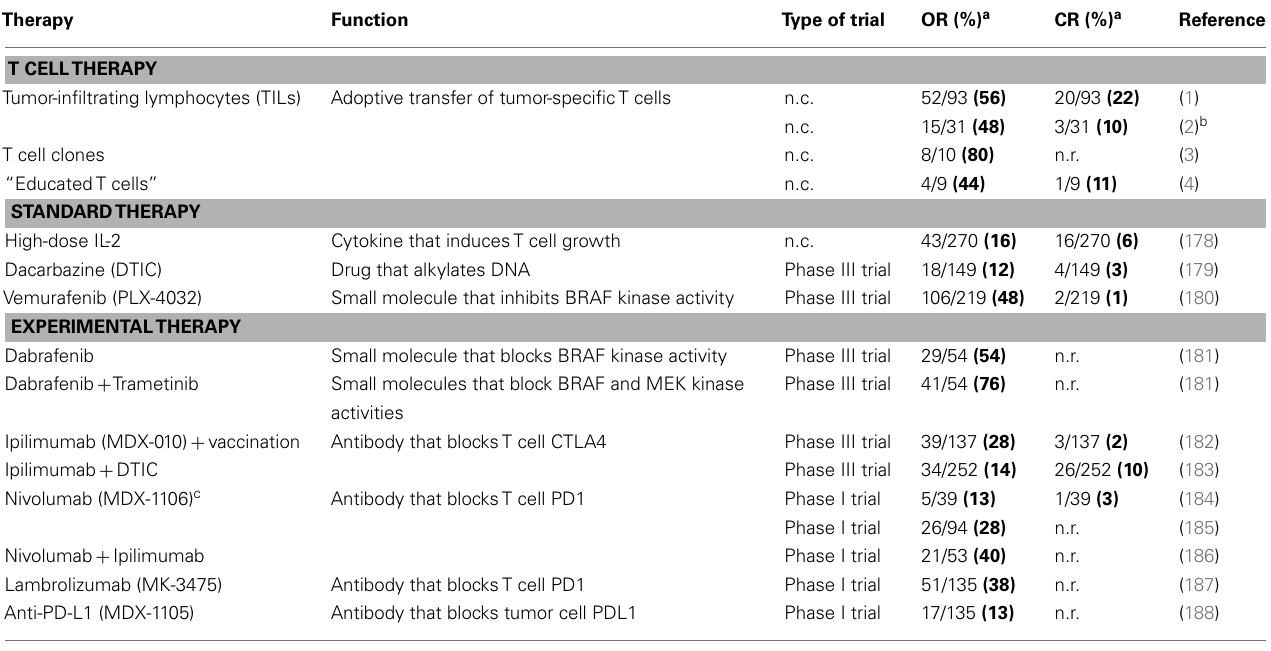
Table 1 | Overview of standard and experimental none-gene-based therapies for metastatic